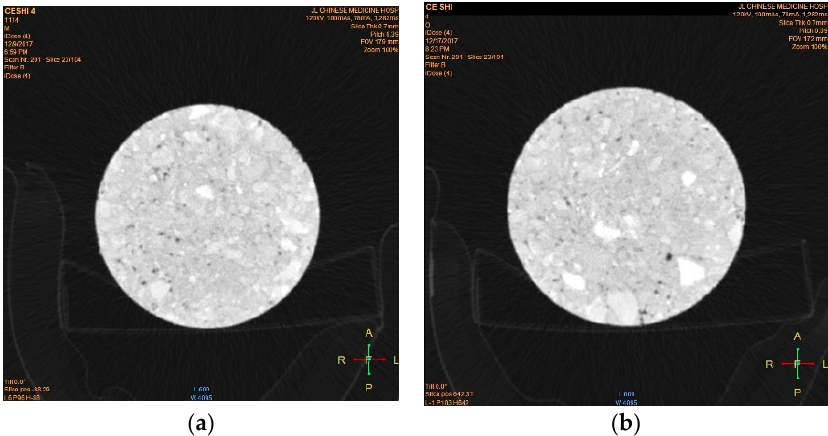
Figure 6. Pre ‐ processed scanning image of matrix asphalt mixture: ( a ) before freeze–thaw cycles; ( b ) after five freeze–thaw cycles.